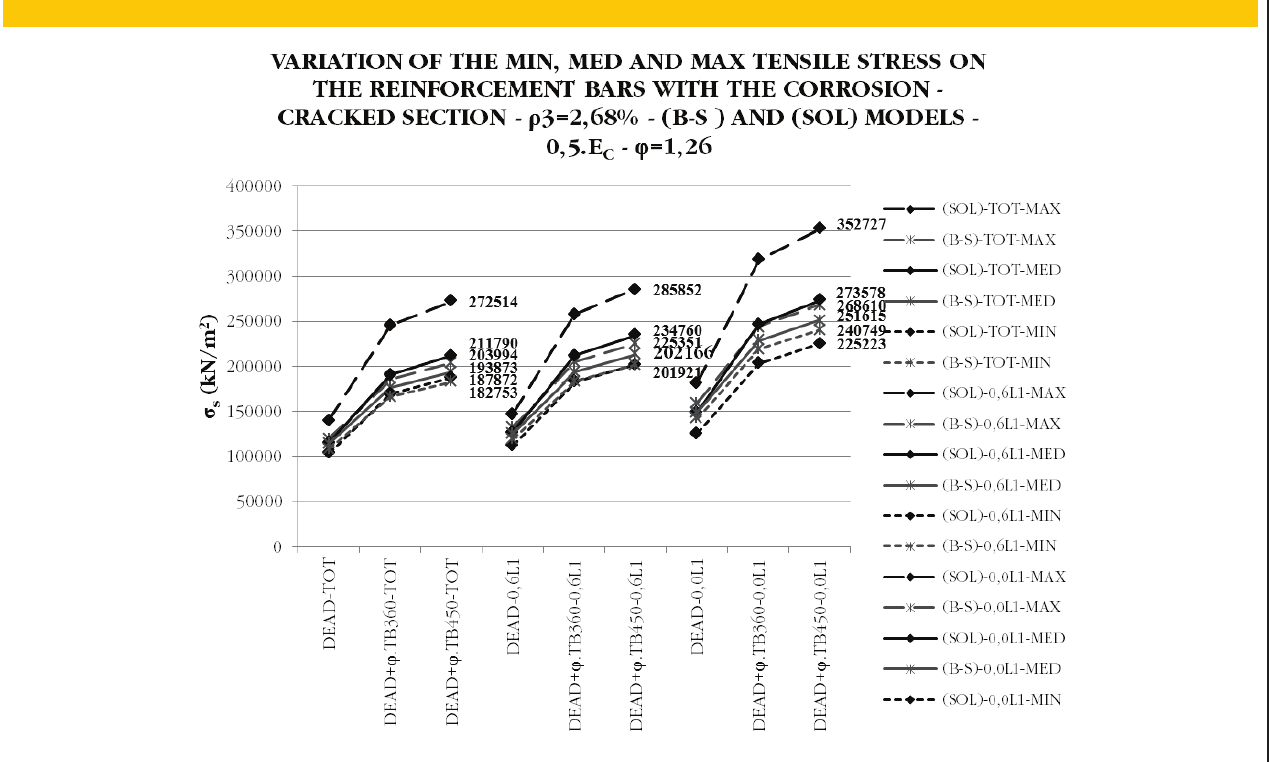
Figure 26 – Variation of minimum, medium and maximum tensile stress in the reinforcement bars with the reinforcement corrosion ( ρ =2,68%), for (B-S) and (SOL) models, in cracked section, modulus 3 of elasticity 0.5.E , with impact, caused by {DEAD}, {DEAD + φ .TB360} and {DEAD + φ .TB450}